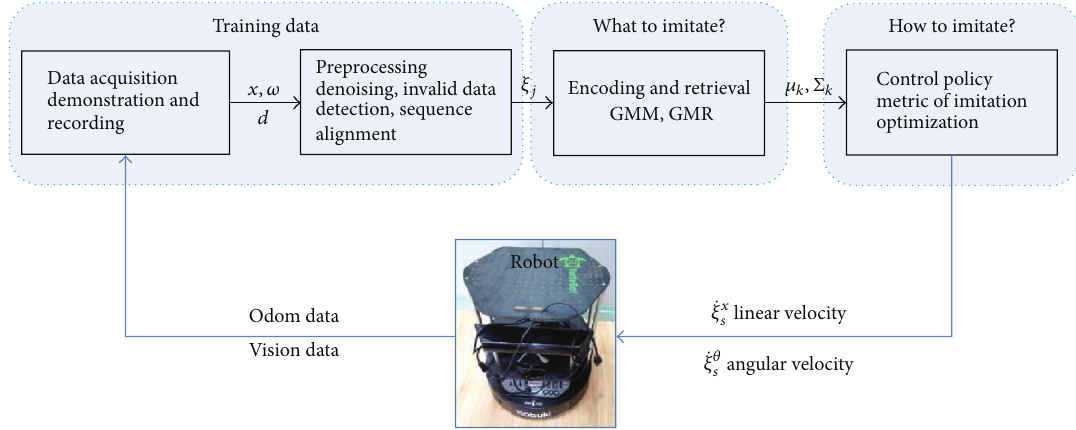
Figure 2: System architecture of obstacle avoidance